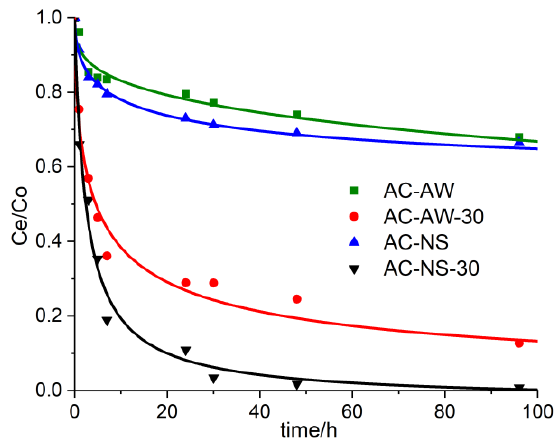
Figure 3. The experimental curves representing the adsorption kinetics of vitamin B 12 into the activated carbons: AC-AW (green squares), AC-AW-30 (red circles), AC-NS (blue triangles), AC-NS-30 (black triangles).